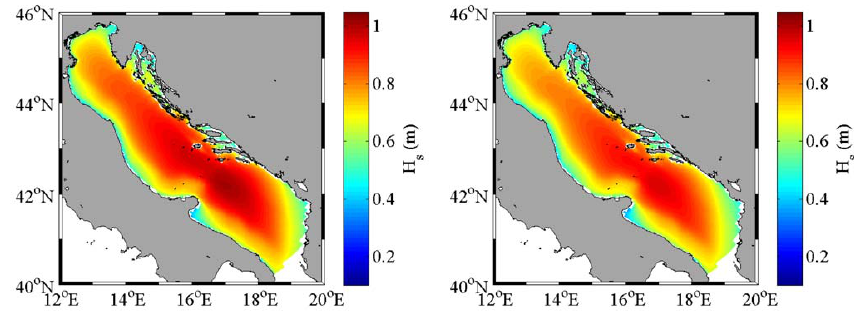
Fig. 8. Average H s (in meters). Numerical simulations of the present climate (left) and the future scenario (right) are shown.